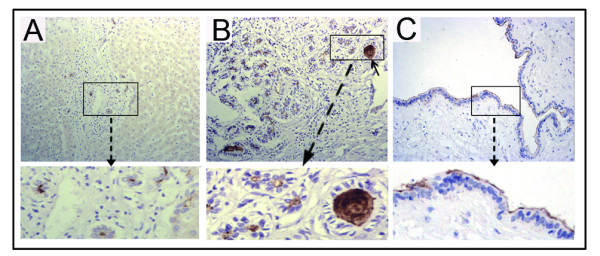
Immunohistochemical staining of CD133 in normal human liver tissues. CD133 expression was found mainly on the apical membrane surface of bile ducts of different sizes in normal liver tissue. (A) Normal small bile ducts, original magnification 200×; (B) Reactive bile ducts, original magnification 200×; (C) Large bile duct, original magnification 400×. In addition, CD133-positive cellular debris in the glandular lumina was observed in some normal bile ducts (B, arrow).